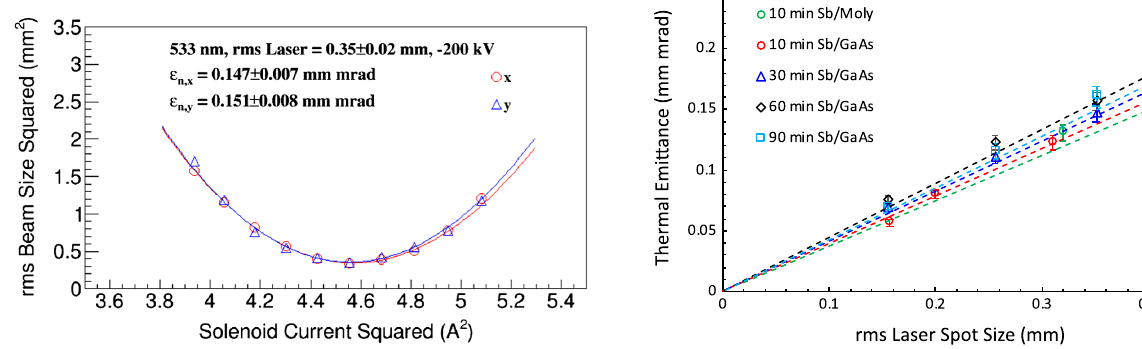
FIG. 6. A measurement of thermal emittance using a solenoid scan.